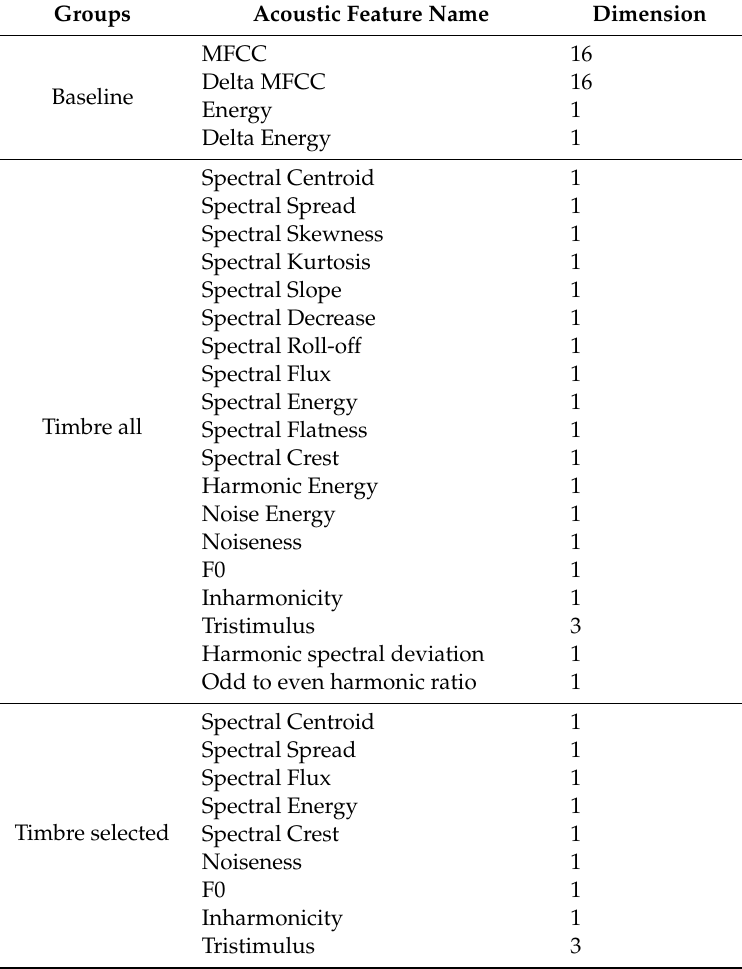
Table 3. Detailed information about acoustic features and their